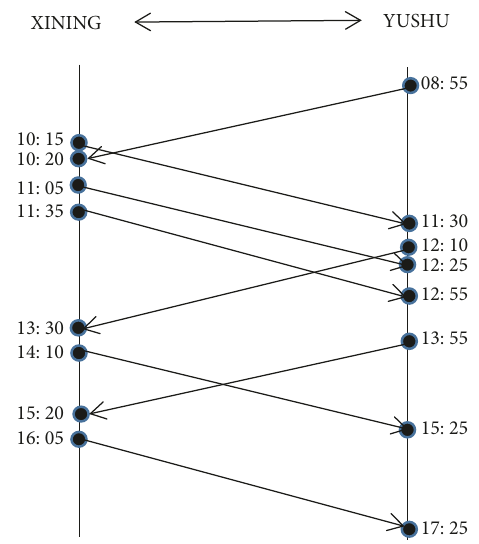
Figure 4: Relationship between a certain route and flight